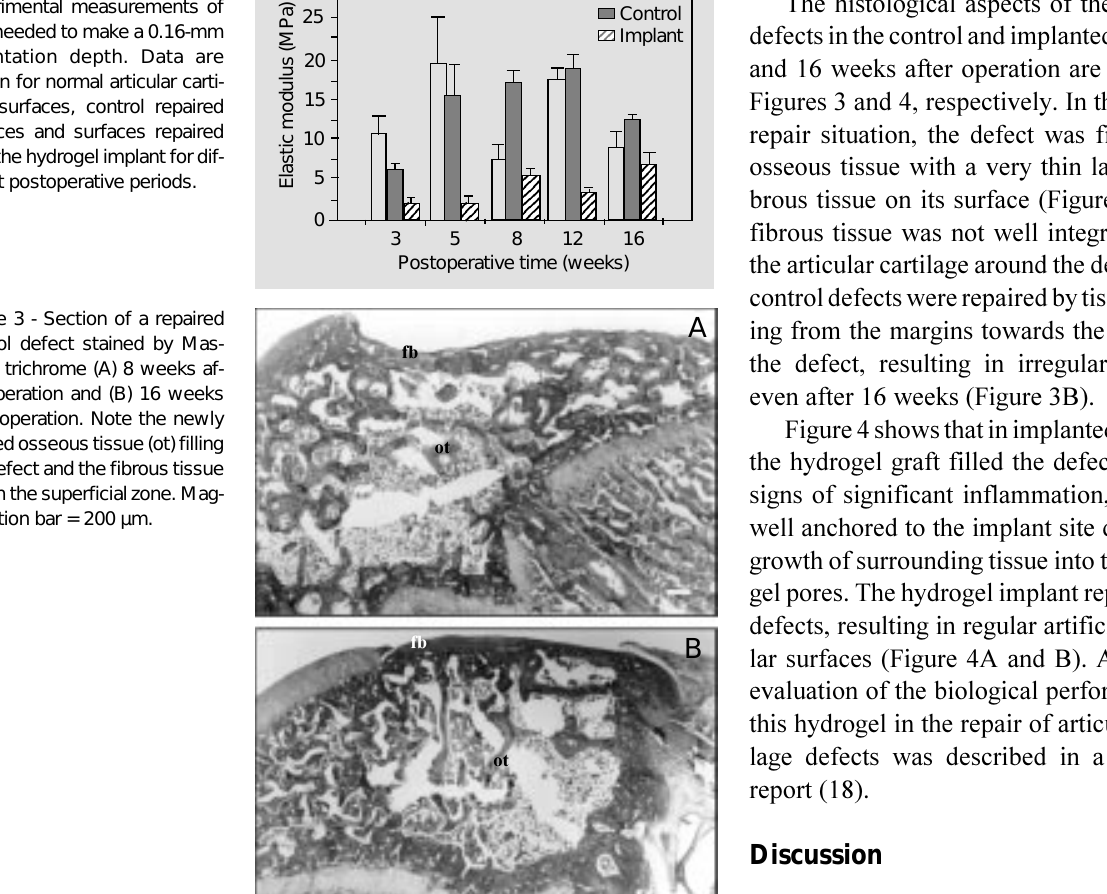
Figure 3 - Section of a repaired control defect stained by Mas- son’s trichrome (A) 8 weeks af- ter operation and (B) 16 weeks after operation. Note the newly formed osseous tissue (ot) filling the defect and the fibrous tissue (fb) on the superficial zone. Mag- nification bar = 200